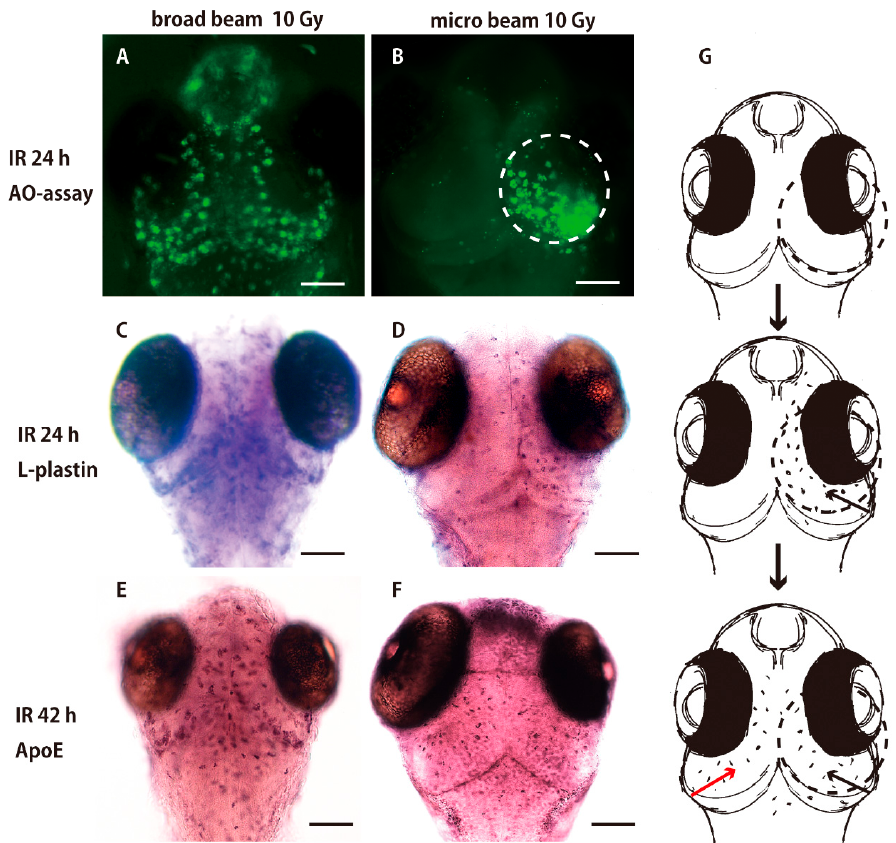
Figure 3. Irradiation targeted to the right hemisphere of OT of medaka embryonic brain. AO-staining of the irradiated brain 24 h after the irradiation demonstrated that AO-positive apoptotic neurons were induced only in the irradiated right hemisphere (dotted circle in B ). By contrast, AO-positive apoptotic cells were induced throughout the whole brain when the whole embryonic brain was irradiated with broad beam (10 Gy) ( A ). When AO-positive apoptotic neurons were induced only in the irradiated right hemisphere ( B ), only the microglia positioned in the irradiated right hemisphere express L -plastin as shown by WISH ( D ), in contrast to that microglia were activated to express L -plastin in the whole brain after whole-brain irradiation ( C ). At the later phase of phagocytosis, 42 h after the irradiation, a large number of microglia express ApoE, not only in the irradiated right hemisphere (black arrows in G ), but also in the left hemisphere (red arrow in G ), which was not irradiated ( F ), in a similar manner to that observed after whole-brain irradiation ( E ). Schematic drawings of the abscopal effect in microglial activation are shown in G . Scale bars = 100 μ m.